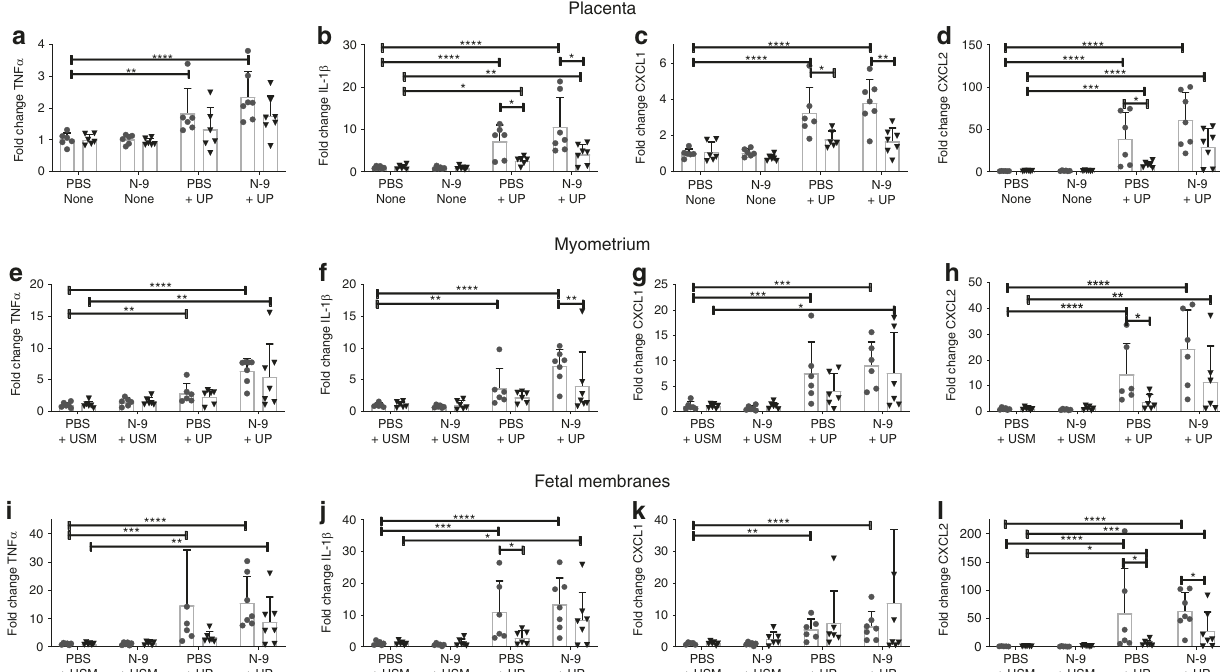
Fig. 9 Cytokine mRNA levels in gestational tissues following vaginal UP infection. In the afternoon of D16 of gestation, mice received either 10% N-9 or PBS control via intravaginal inoculation. After 16 h, in the morning of D17 of gestation, mice received either UP or USM control via intravaginal inoculation. Tissues were collected 48 h later and analysed using RT-qPCR. Mice that were infected with UP (PBS + UP, n = 6; N-9 + UP, n = 7) had an increase in the mRNA levels of TNF α ( a , e , i ), IL-1 β ( b , f , j ), CXCL-1 ( c , g , k ) and CXCL-2 ( d , h , l ) compared to vehicle-treated controls (PBS + USM, n = 6). The effect was stronger at the proximal site. Error bars indicate SD. Statistical signi fi cance of the treatment effect was assessed using Dunnett ’ s multiple comparisons test on the DDCt values against the PBS + USM group for the proximal and distal site. Statistical signi fi cance for the site effect was assessed unpaired t test for proximal vs. distal for each treatment group (* P < 0.05, ** P < 0.01, *** P < 0.001, **** P < 0.0001) ( n = 6 for N-9 + USM). Source data are provided as a Source Data fi le.